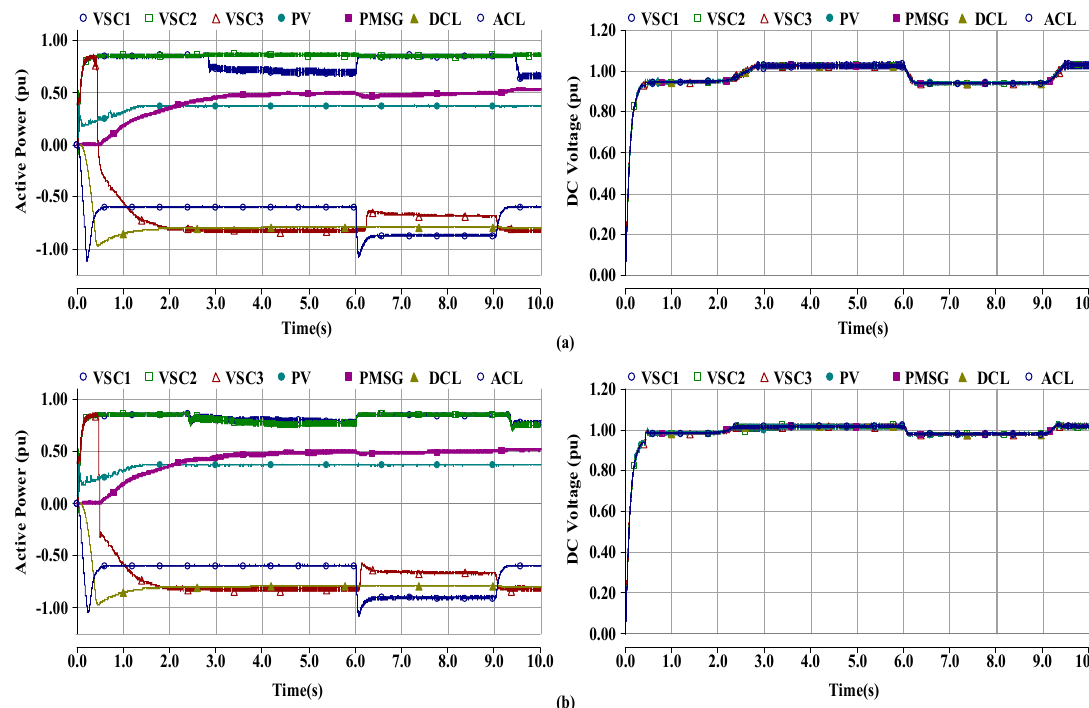
Figure 6. Active power and DC voltage of the primary controller; ( a ) droop with a dead-band and ( b ) adaptive droop with a dead-band and VSG.